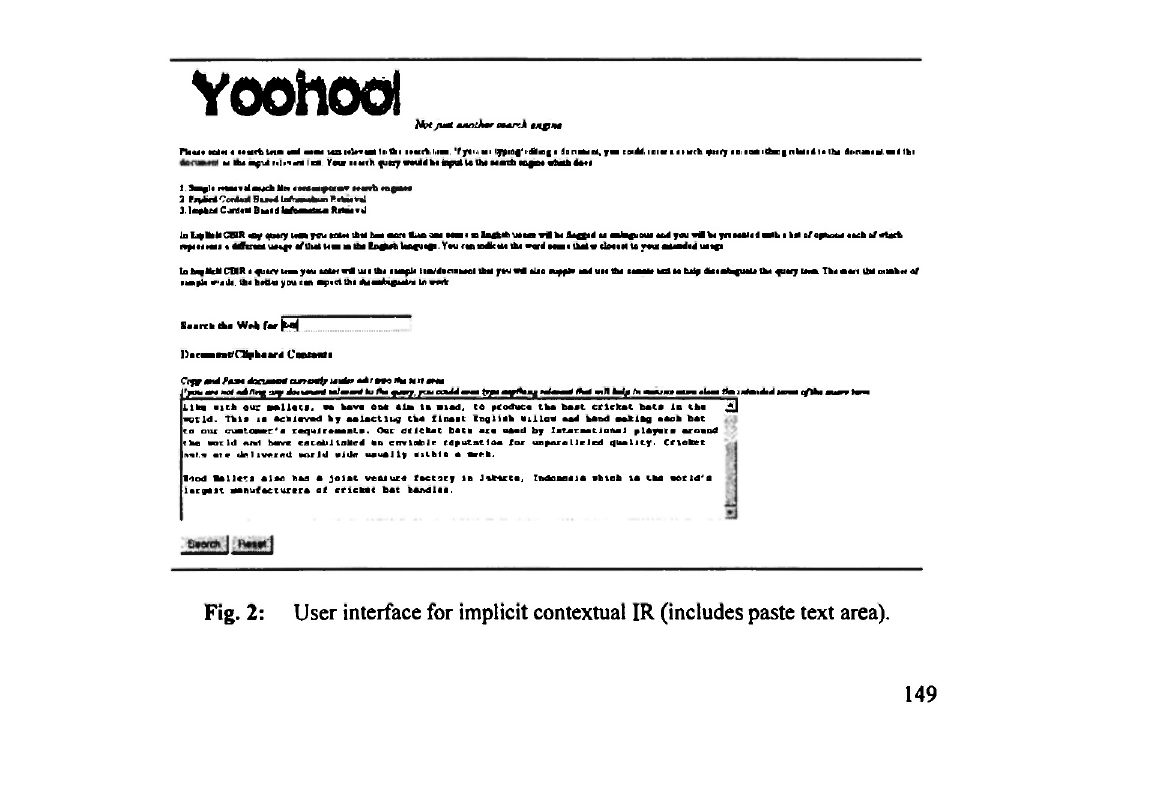
Fig. 2: User interface for implicit contextual IR (includes paste text